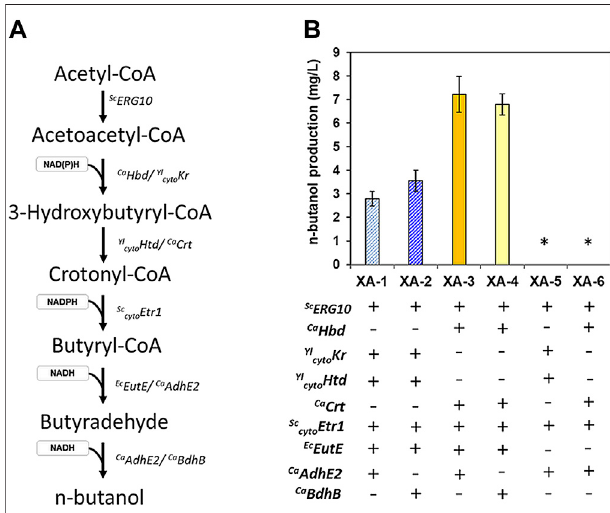
FIGURE1| n-butanolproductionintheglucose/xyloseco-fermenting S. cerevisiae strains expressing various gene sets used for n-butanol biosynthesis.Thegenesweresourced from S.cerevisiae ( Sc ), Y.lipolytica ( Yl ), E. coli ( Ec ), and C. acetobutyricum ( Ca ). Low-cell density fermentations (initial OD of 0.2) were conducted with 20 g/L xylose as the sole carbon source. (A) n-butanol pathway showing the genes used in this study. (B) butanol titer of the strains expressing six combinations of genes used to construct various n-butanol-production pathways. The error bars represent the standard deviations obtained using biological triplicates. *: below the detection limit of 2.5